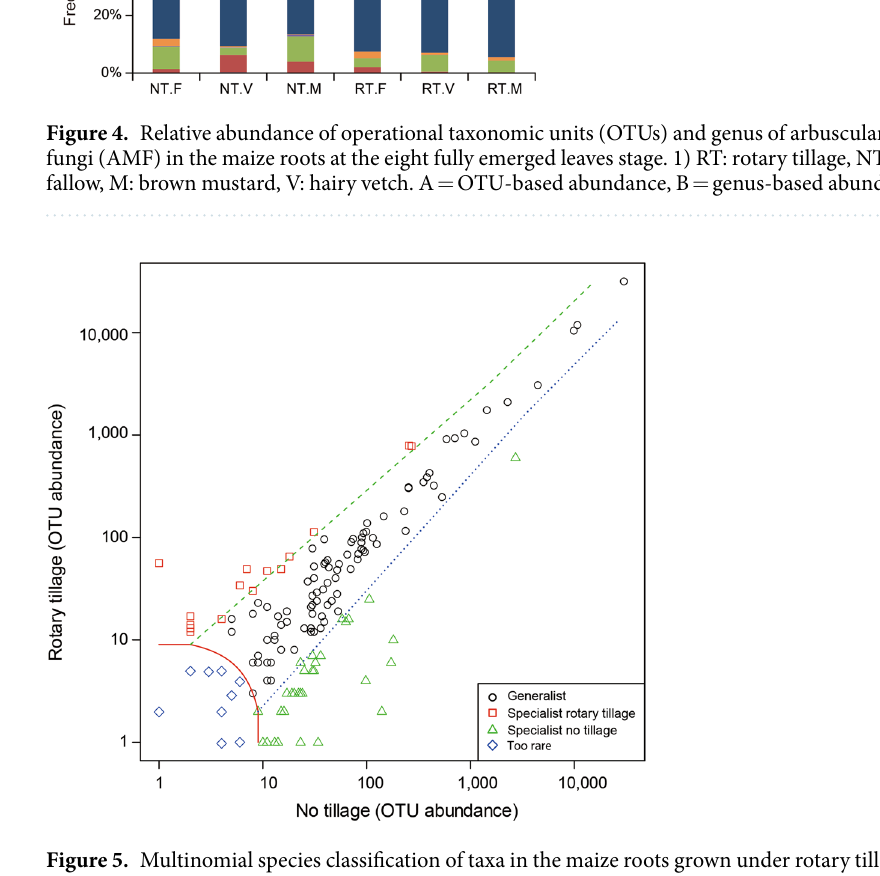
Our findings indicate that representatives of Glomeraceae ( Glomus and Rhizophagus ) and Claroideoglomeraceae ( Claroideoglomus ) are the main genera in maize roots (Fig. 4B and